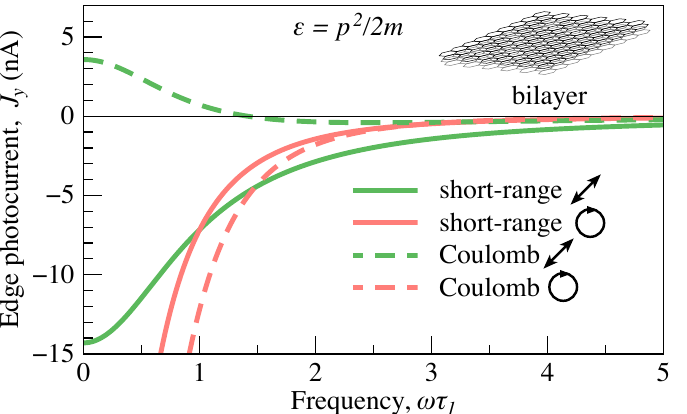
Figure 3. Frequency dependence of the edge photocurrent in 2D systems with parabolic energy dispersion. Solid curves correspond to short-range scatterers and linearly polarized field with S 2 = E 2 (green curve) and circularly polarized field with S 3 = E 2 (red curve). Dashed curves present the results for scattering by charged impurities. The curves are calculated after Equation (22) for parameters corresponding to bilayer graphene: m ∗ = 0.03 m 0 , n = 5 × 10 11 cm − 2 , τ 1 ( E F ) = 1 ps, and E = 8 V/cm corresponding to the radiation intensity I = 1 W/cm 2